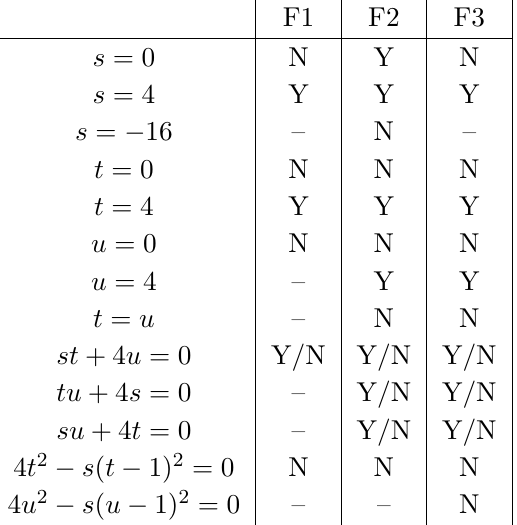
s t to show the crossing symmetry. (cid:0) (cid:0)